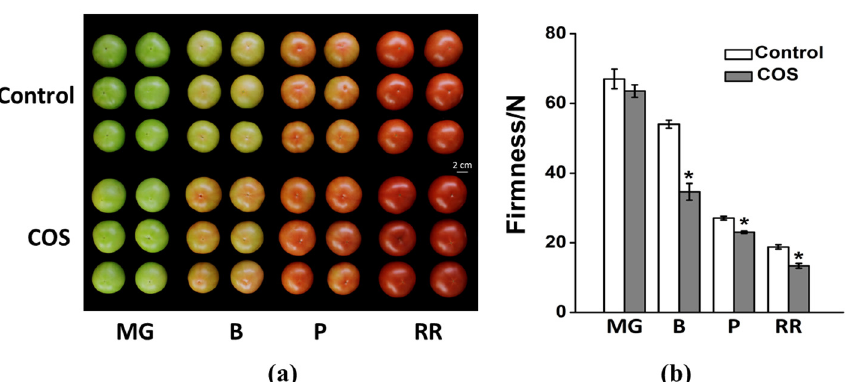
Figure 1. Effect of COS on the coloring ( a ) and firmness ( b ) of tomato fruits. In ( b ), data represent the means ± SD of six fruits. The asterisk represents a significant difference compared with the con ‐ trol based on Student’s t ‐ test (* p < 0.05). MG: mature green; B: breaker; P: pink; RR: red ripened. FW: fresh weight. FW: fresh